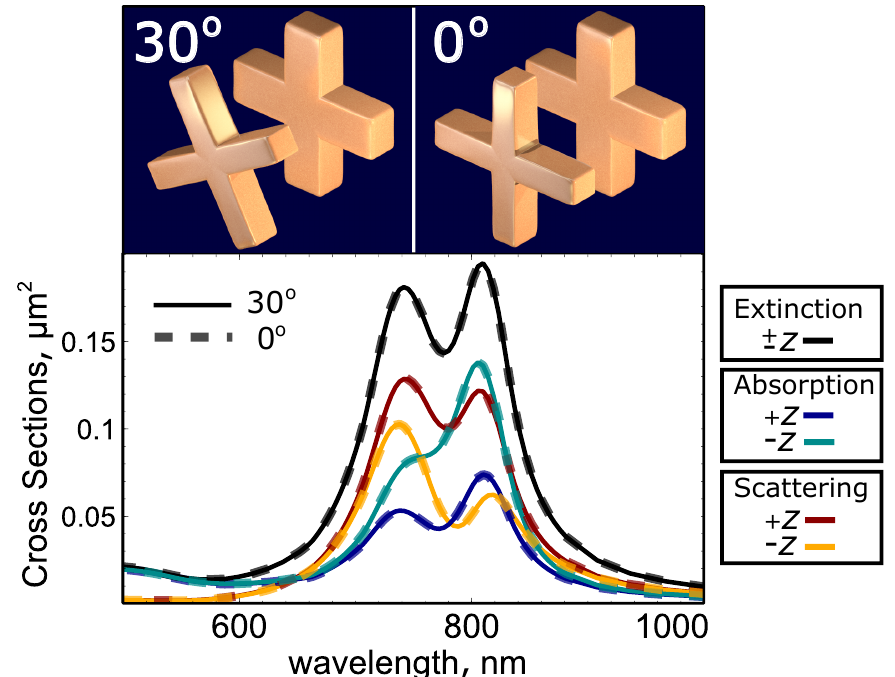
Figure 3. Simulated nonreciprocal scattering and absorption cross-sections in stacked gold nanocrosses from linearly-polarized plane waves propagating in opposite directions ( ± z ) along the rotational symmetry axis. Simulation results are shown to be the same for both chiral ( C ) and achiral ( C ) structures, and both are indepedent of polarization. The 4 4 v calculation parameters are given in the